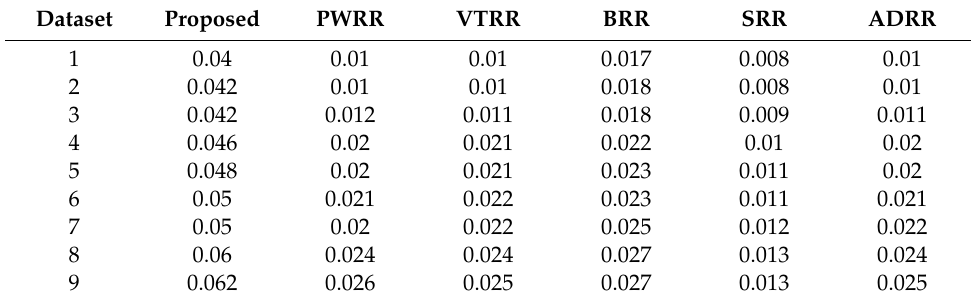
Table A1. Running times comparison between the proposed algorithm and five scheduling algorithms.